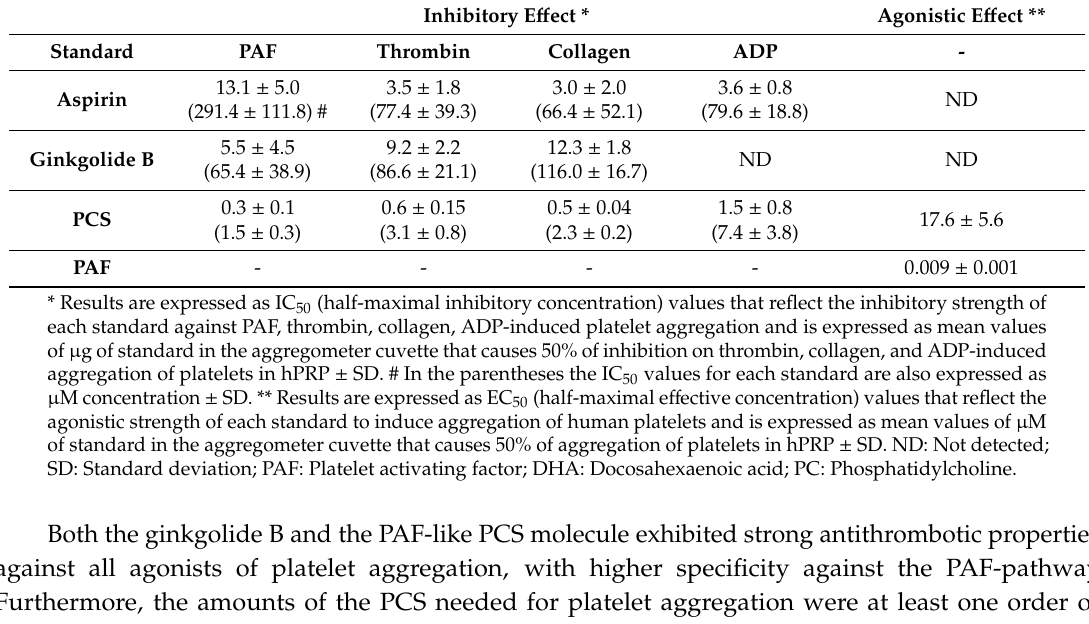
Table 3. Antagonistic and agonistic e ff ects of standards of aspirin, ginkgolide B, and 1-hexadecyl-2-docosahexaenoyl- sn -glycero-3-phosphocholine (PCS) against PAF, thrombin, collagen, and ADP on human platelets (hPRP). Inhibitory E ff ect *